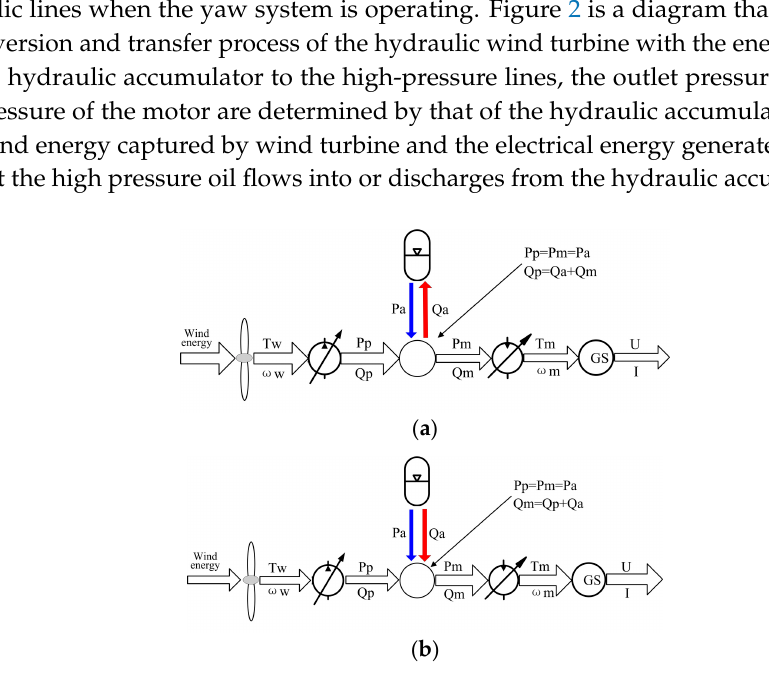
Figure 2. Energy conversion and transfer chart of the hydraulic wind turbine. ( a ) Hydraulic oil flowing into hydraulic accumulator; ( b ) hydraulic oil discharging from hydraulic accumulator.